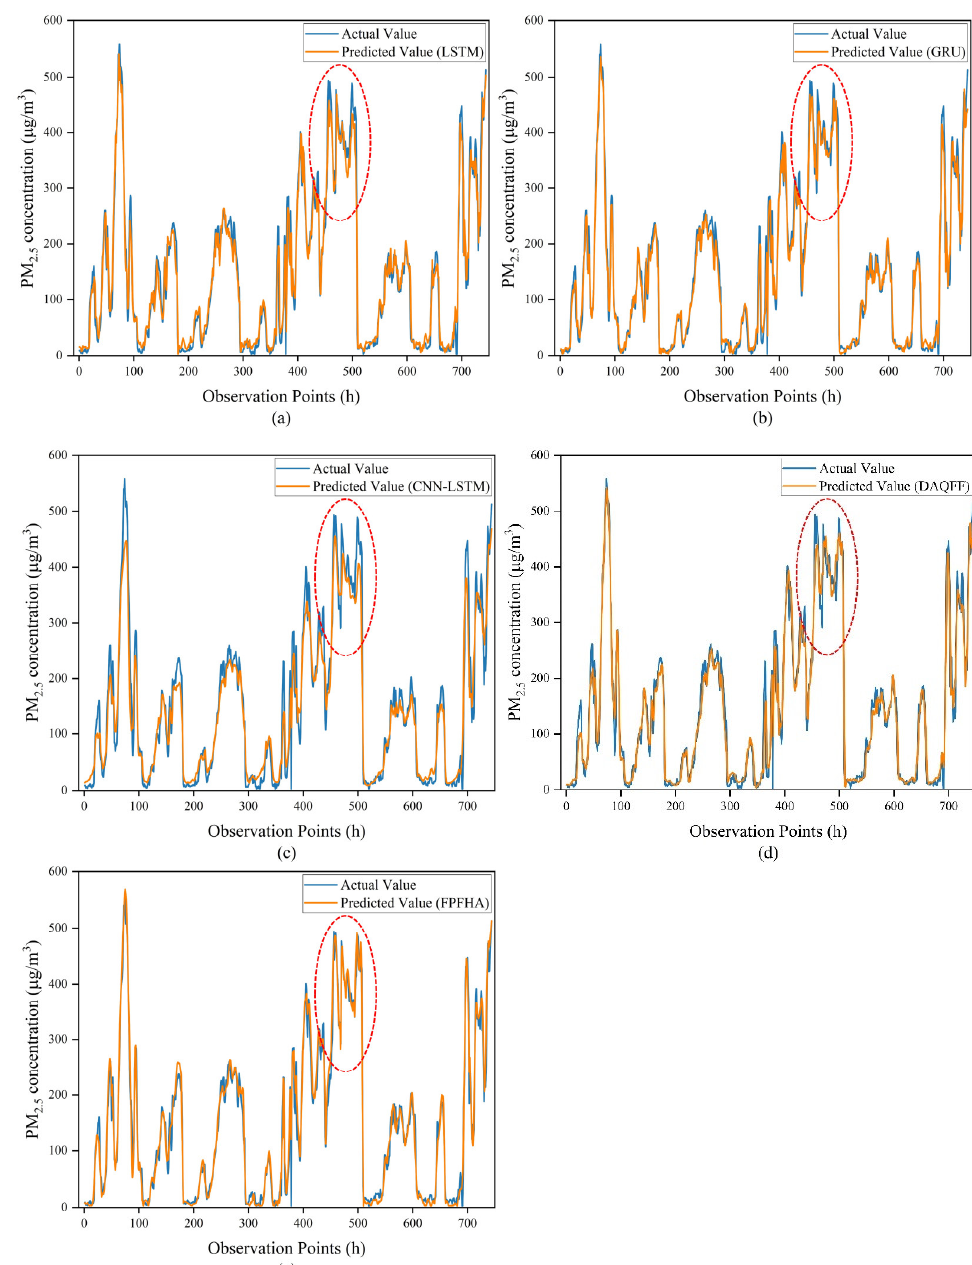
Figure 9. Predictions 12 h ahead in experiments on the Beijing dataset. The graphs compare one month’s worth of actual and predicted PM2.5 values (1 December 2016–31 December 2016) at station 1003A with different models. ( a ) LSTM; ( b ) GRU; ( c ) CNN-LSTM; ( d ) DAQFF; ( e ) FPHFA.